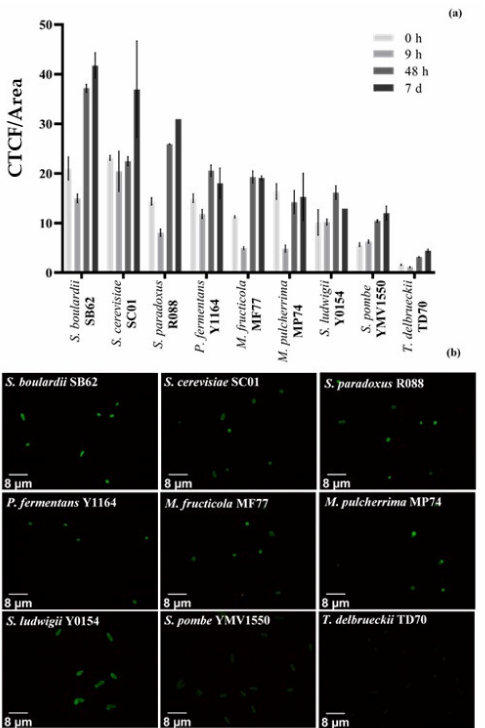
Figure A1. Fluorescent images and corrected total cell fluorescence (CTCF) obtained from the initial screening of all evaluated yeast strains: S. boulardii SB62, S. cerevisiae SC01, S. paradoxus R088, P. fermentans Y1164, M. fructicola MF77, M. pulcherrima MP74, S. ludwigii Y0154, S. pombe YMV1550 and T. delbrueckii TD70. ( a ) CTCF normalized by cell size, for samples collected at 0 h, 9 h, 48 h and 7 days after inoculation into enrichment medium and stained with FITC-ConA before fluorescence imaging. The data points shown are means for two biological staining repeats, calculated from the means of two technical repeats, derived from the means of five images, from which the mean CTCF/area for each cell captured was used. The error bars indicate standard deviation between biological repeats. ( b ) Fluorescent images taken of samples collected 48 h after inoculation into enrichment medium, using the Zeiss Axiocam 208 with constant exposure time. Scale bars represent 8 µ m. Image analysis was performed using ImageJ